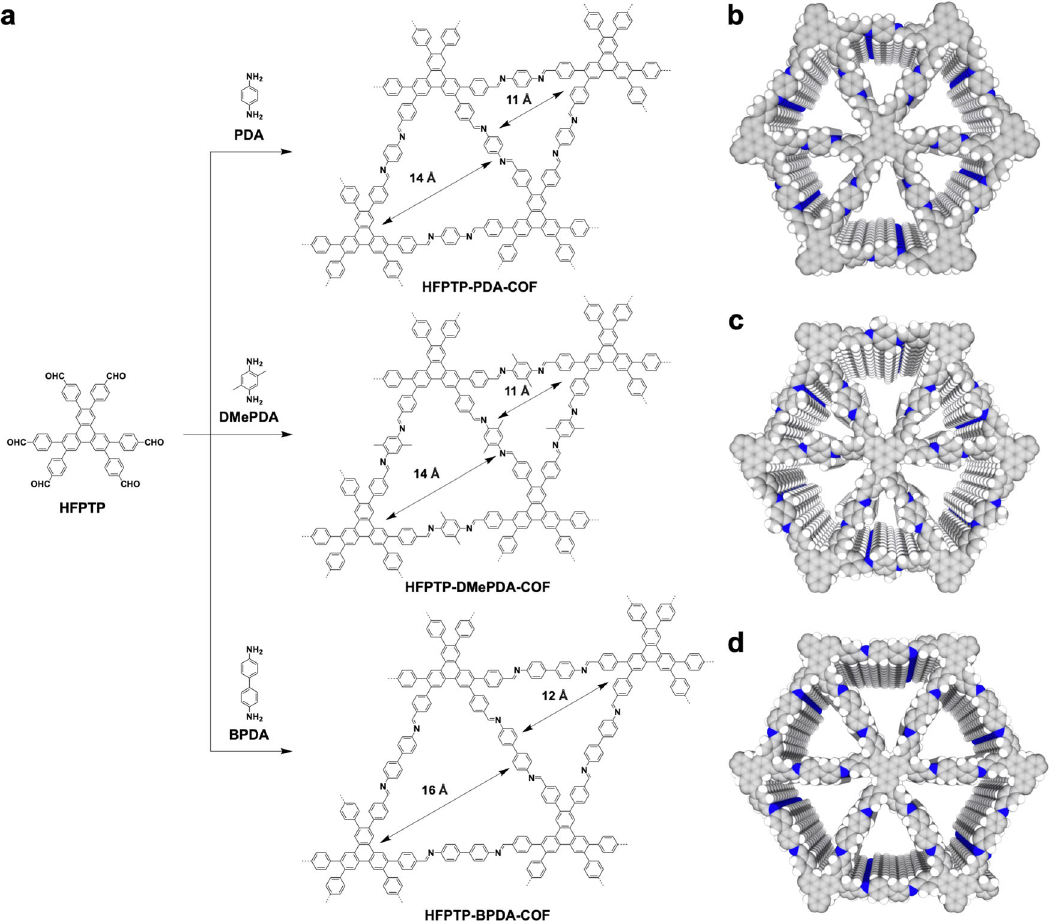
Fig. 1 Hydrophobic supermicroporous 1D channels in trigonal COFs. a Schematic of synthesis of HFPTP-PDA-COF, HFPTP-DMePDA-COF and HFPTP- BPDA-COF. Reconstructed structures of ( b ) HFPTP-PDA-COF, ( c ) HFPTP-DMePDA-COF and ( d )